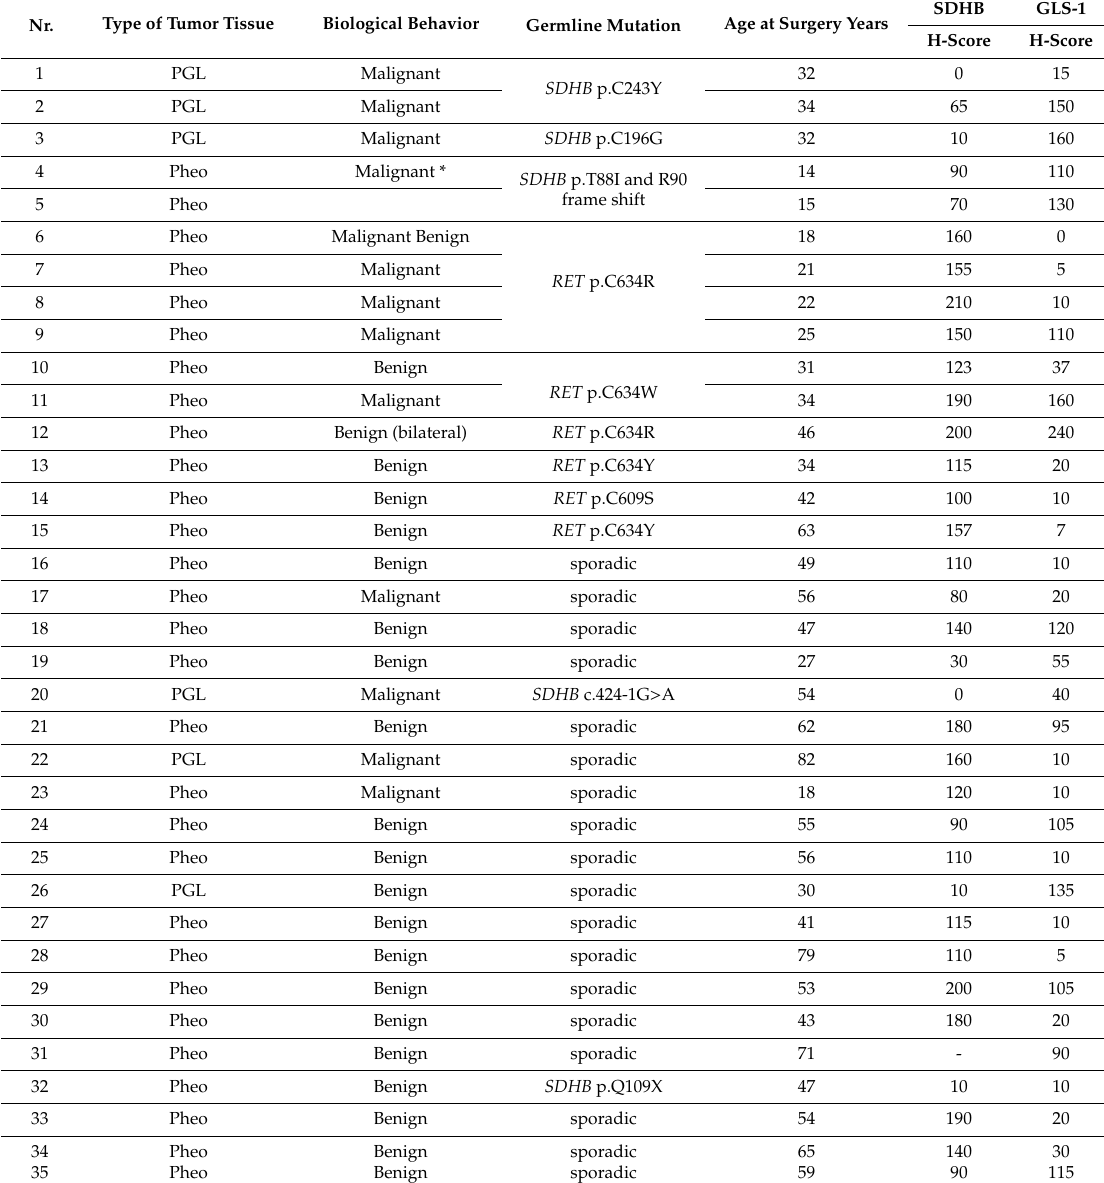
Table 1. Immunohistochemical evaluation of expression of SDHB and GLS-1 in Pheo / PGL tumor